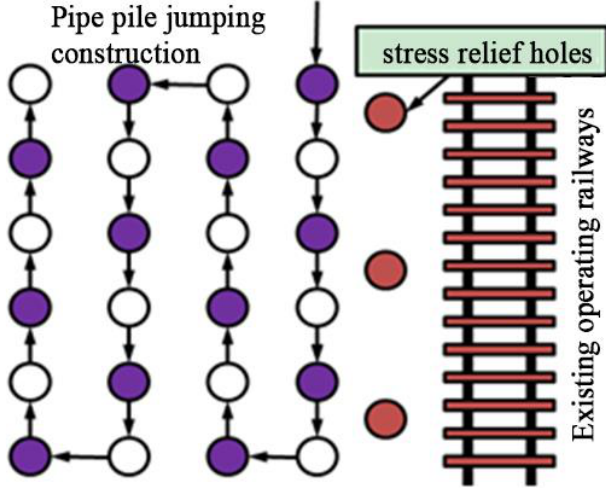
Figure 15. Pile construction optimization technology schemes.